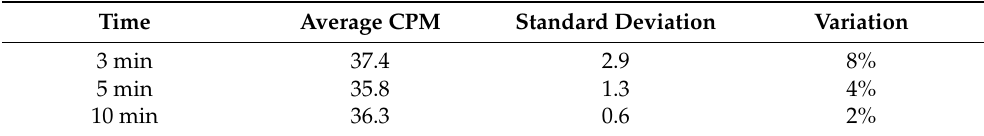
Table 1. Average counts per minute (CPM) measured for a 2.56 MBq I-131 capsule and associated error for each SGP sensor count time option.